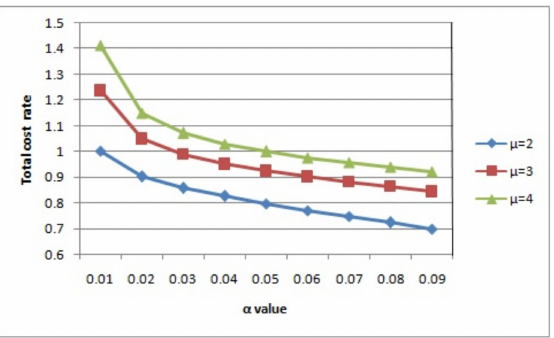
Figure 3. TC (32,11) vs. α , H = 8; β = 0.95; N = 3; γ = 0.6; C C = 0.1; C S = 0.8; C B = 0.07; C P = 0.05; C R = 0.1; C W =